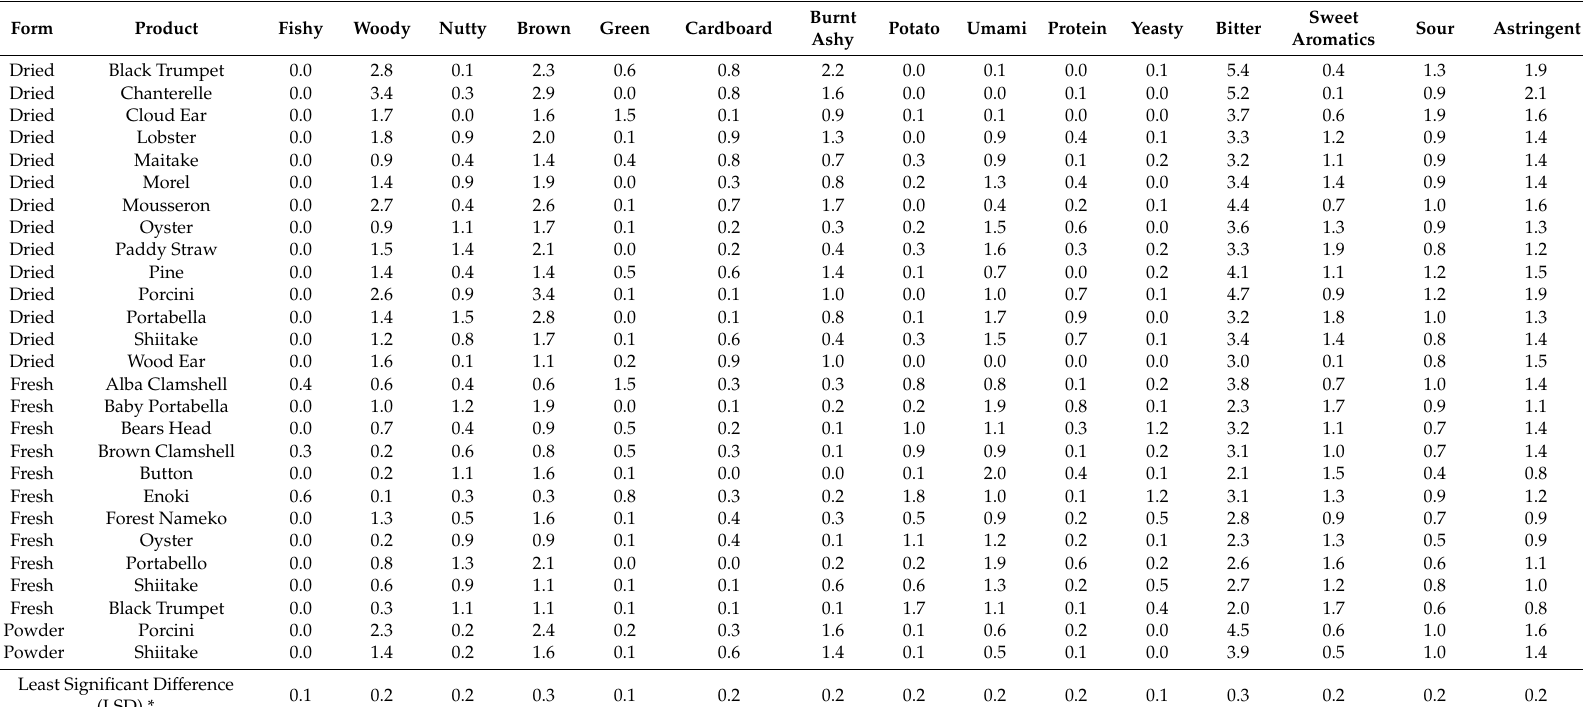
Table 4. Mean intensity of other flavors in selected mushroom broths (0 = none to 15 = extremely